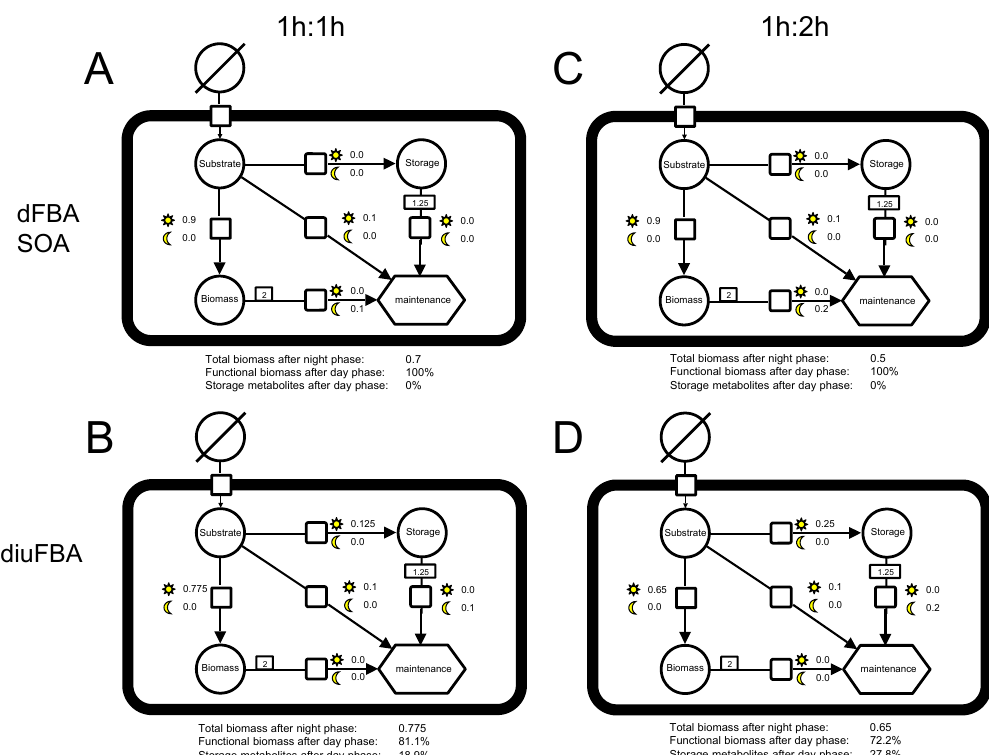
Figure 2. Four instances of the SBGN (Systems Biology Graphical Notation) graph [21]